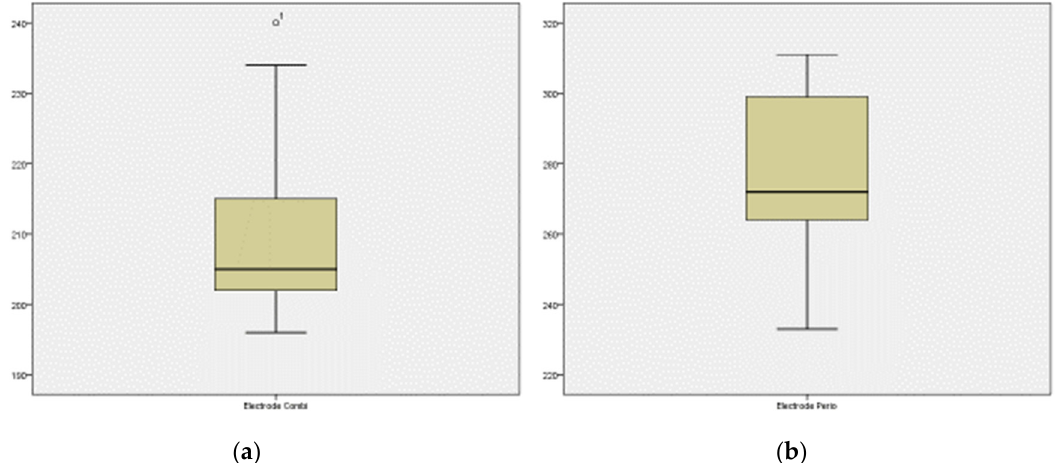
Figure 6. Box plot of the total bone-to-implant contact (BIC) obtained with control and UVC-treated surfaces. Plots show the lower (Q1), median (Q2), and upper (Q3) quartiles. The whiskers indicate the highest and lowest observations. ( a ) Box plot of the combination electrode potential in mV. ( b ) Box plot of the periodontal electrode potential in mV.